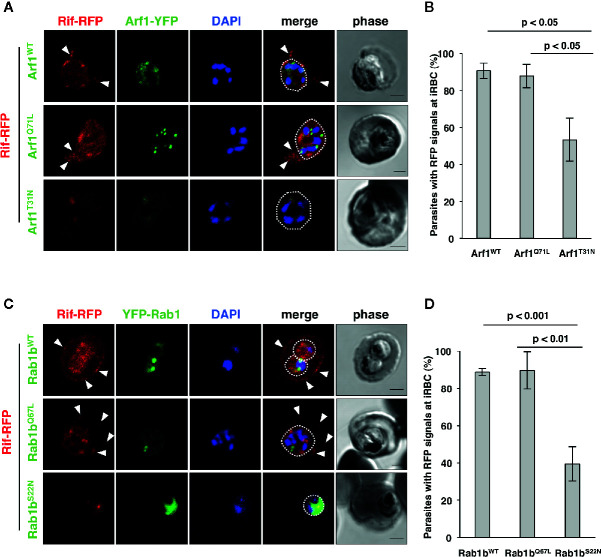
PfArf1 and PfRab1b regulated the export of PEXEL-positive Rifin to the erythrocyte cytoplasm. Parasites expressing Rifin-RFP and PfArf1-YFP-DD (A, B) or DD-YFP-PfRab1b (C, D) were examined via the immunofluorescence assay. Fluorescence signals from RFP (red), YFP (green), and DAPI (blue) are shown. Wild-type PfArf1 or PfRab1b (upper panels), active mutant PfArf1Q71L or PfRab1bQ67L (middle panels), and the inactive mutant PfArf1T31N or PfRab1bS22N (lower panels) are shown. White dotted lines indicate the parasite plasma membrane. The arrowheads indicate dot-like exported Rifin-RFP signals. The bars indicate 2 µm. The rate of parasites that showed a Rifin-RFP signal was detected in the erythrocyte cytoplasm in PfArf1-RFP (B) and RFP-PfRab1b (D) expressing cells are shown in graphs. Thirty individual early trophozoites and early schizonts were counted from three independent experiments. Infected RBCs, recognized by the DAPI and YFP signals under the microscope, were imaged by the laser microcopy, and then analyzed for the localization of RFP and whether Rifin-RFP was exported to the iRBC. The statistical significance was determined using the Student’s t-test.